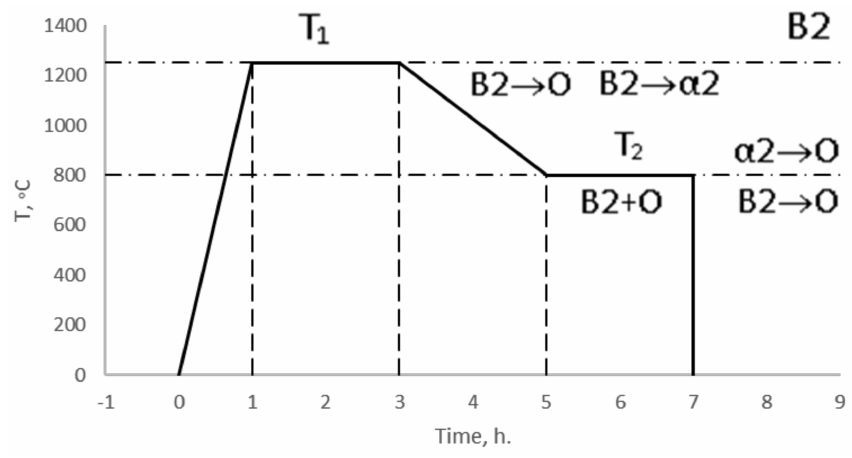
Figure 7. Temperature—time scheme for processing samples of the Ti-Al-Nb system.